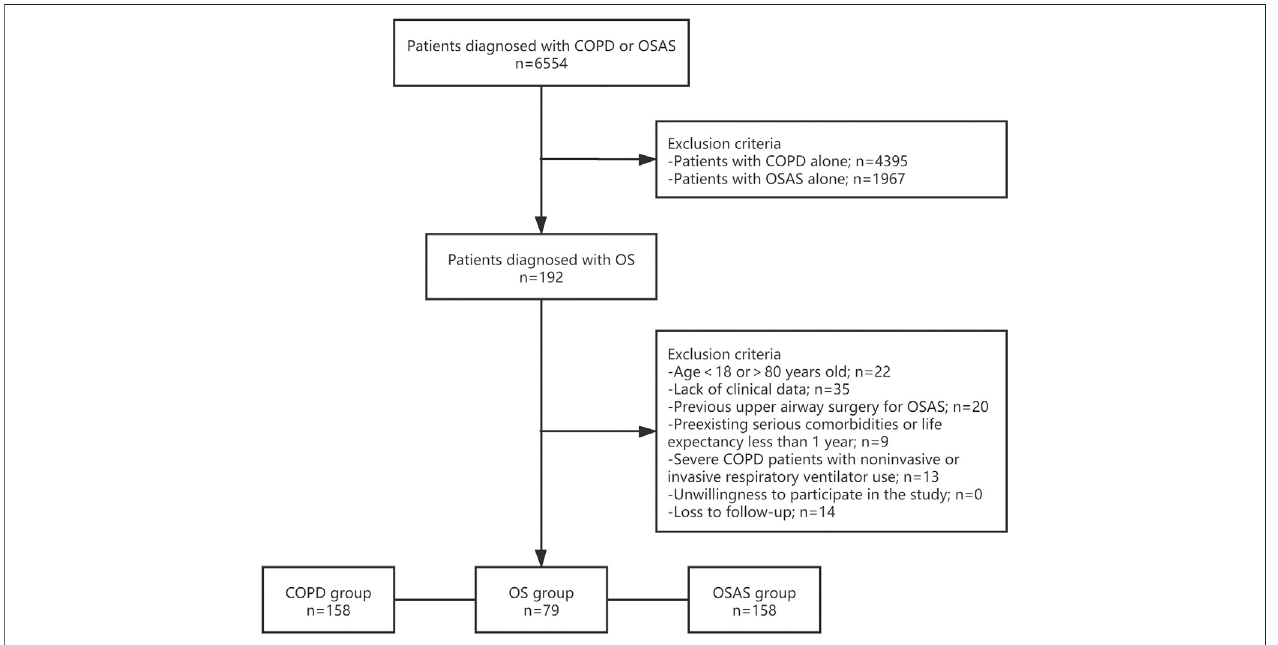
FIGURE1| StudyProtocol. Flowchartoftheselectionprocessofthecurrentstudy.OS,overlapsyndrome;COPD,chronicobstructivepulmonarydisease; OSAS, obstructive sleep apnea syndrome.